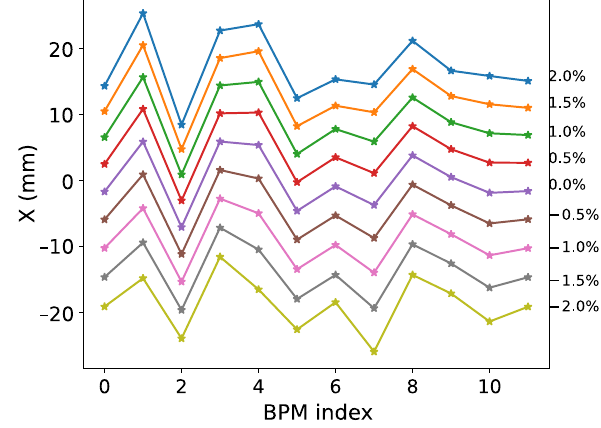
orbit.FIG. 10. Simulation of orbit correction for various cases of missing BPMs. Red (star): Simulated perturbed orbit in MAD - X in the y plane of SIS18. Magenta (diamond): Corrected orbit using all BPMs. Green (tri_up): Corrected orbit using the predicted orbit position for the missing BPMs. Black (times): Corrected orbit excluding the rows corresponding to the missing BPMs from the ORM. Blue (circle): Corrected orbit by taking the zero orbit position at the missing BPM locations.